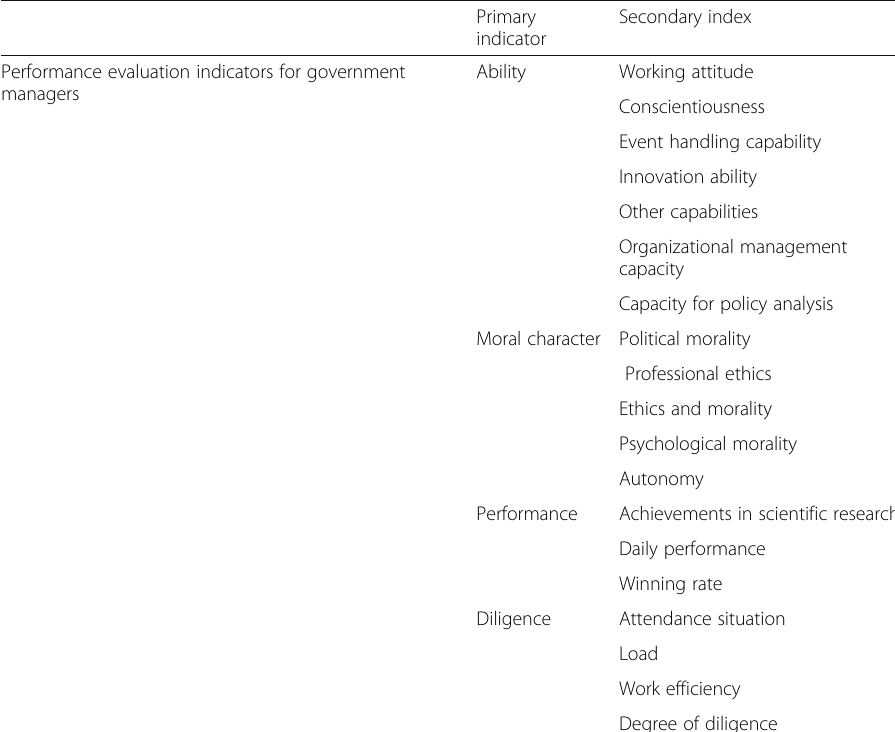
Table 1 Performance evaluation indicators for government